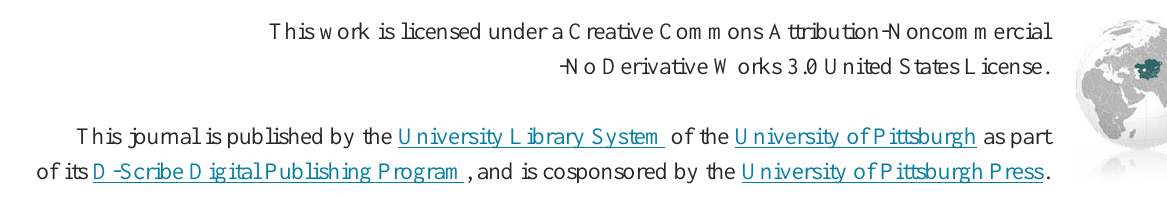
Figure 6: The death rate from cardiovascular diseases in Kyrgyzstan, ages